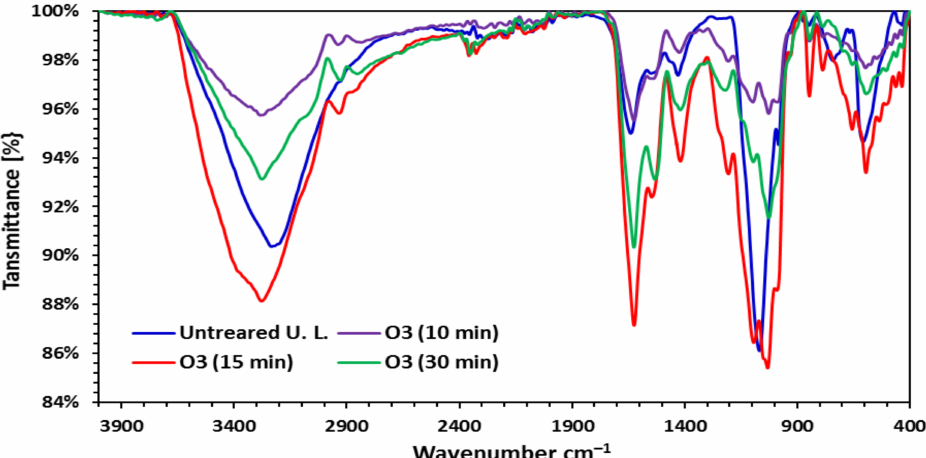
Figure 1. Fourier Transform Infrared (FTIR) spectrum of raw and ozonated pretreated Ulva lactuca